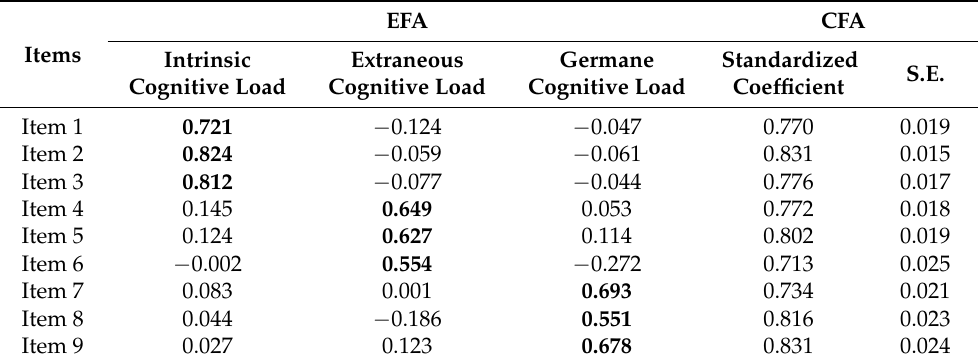
Table 3. Factor loading of EFA and unstandardized and standardized coefficients of CFA.